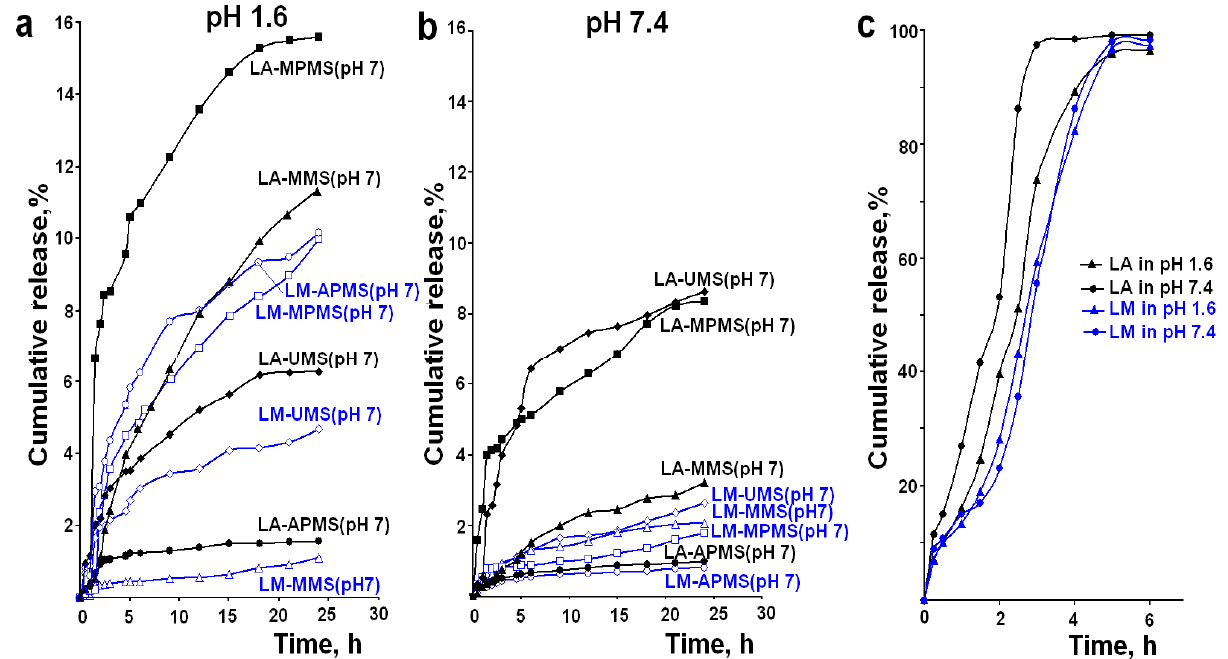
Figure 2. Release profiles of LA–silica composites (black line) and LM–silica composites (blue line) in the media with pH 1.6 ( a ) and 7.4 ( b ). Release profiles of LA and LM from pure powder samples in the media with pH 1.6 and 7.4 ( c ). The release data are presented as mean values of three measurements).